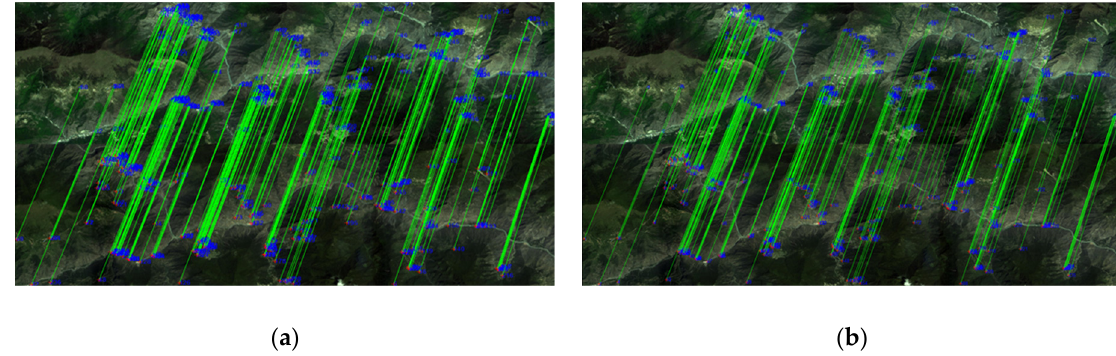
Figure 7. The GF-1 image pairs after eliminating false matches: ( a ) Finely matched by the RANSAC (Random Sample Consensus) algorithm; ( b ) finely matched by the KNN-TAR (K-Nearest Neighbor-Triangle-Area Representation) algorithm. Table 1. Comparison of the KNN-TAR and RANSAC algorithms for GF-1 images.